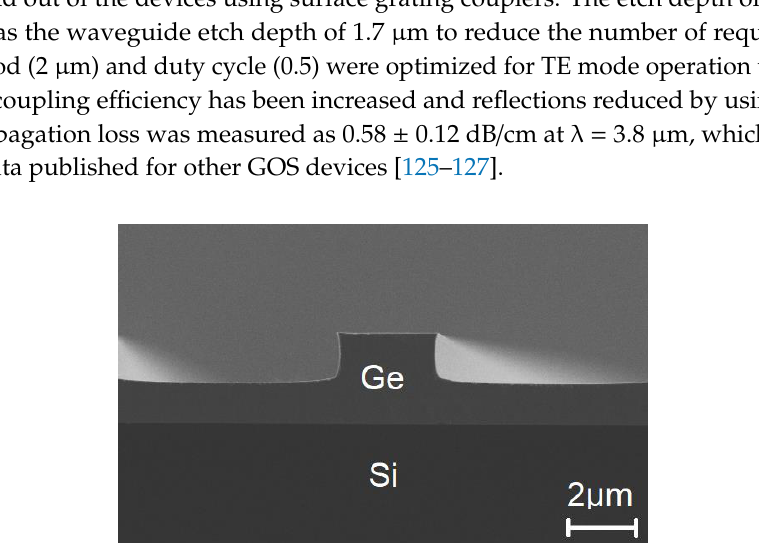
which will be available in the CORNERSTONE Process Design Kit